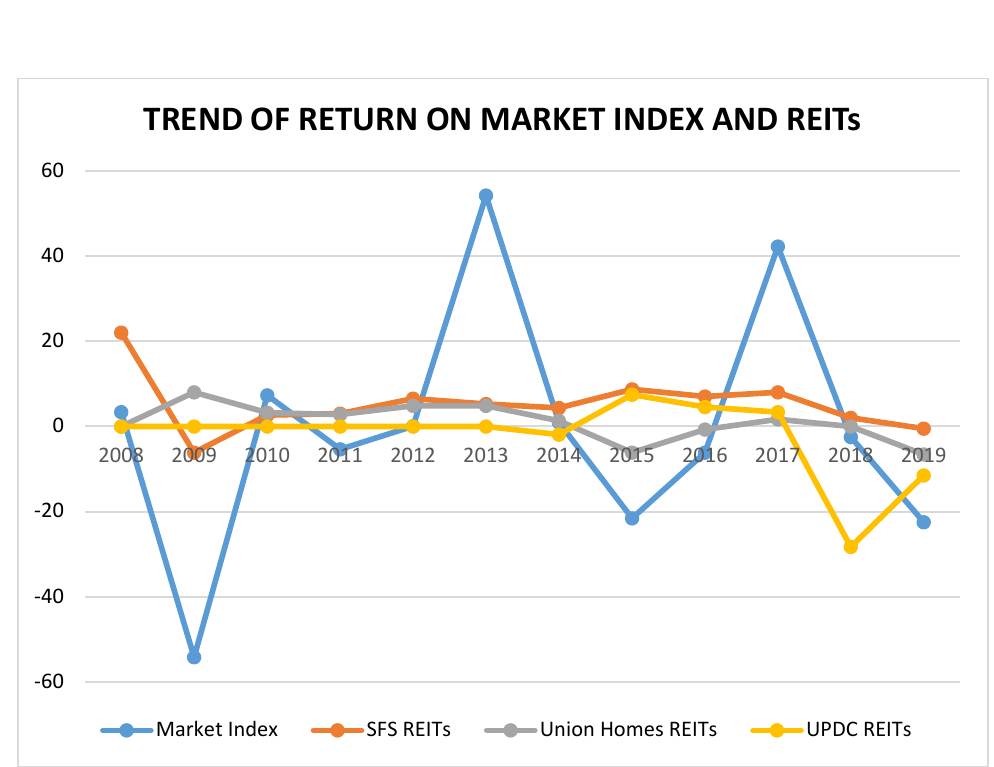
Fig. 1. Trend of returns on indirect real estate investment and market index.